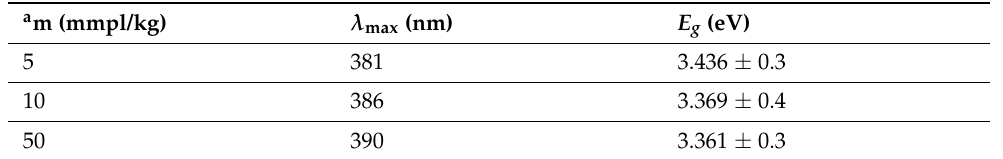
Figure 4. ZnO-NPs and P . granatum leave extract spectra measured using an UV-visible spectropho- tometer. (Inside: photograph of ZnO-NPs synthesized via green method). Table 2. λ max and energy band gap ( E g ) results of ZnO-NPs at three different concentrations of zinc nitrate